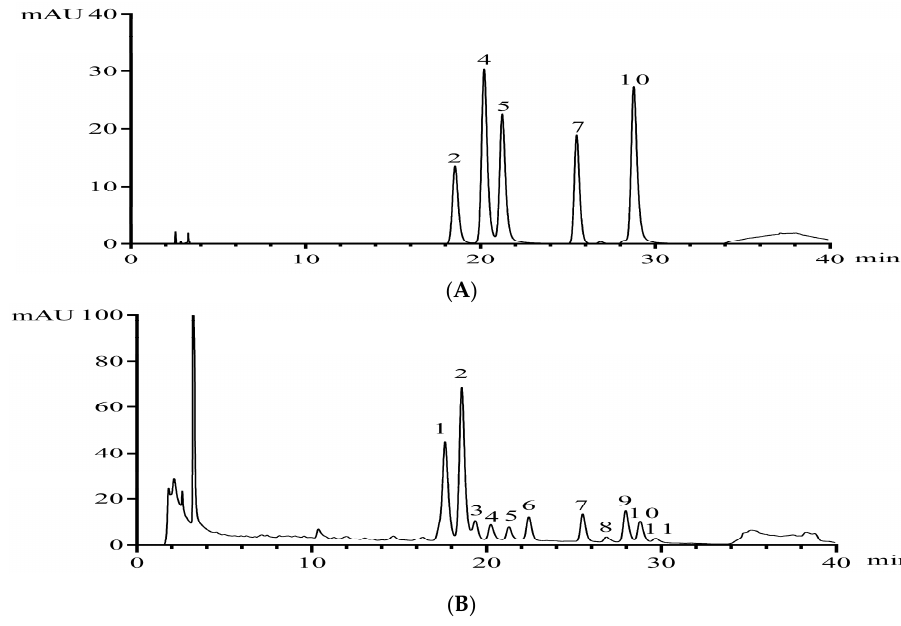
Figure 1. A representative high performance liquid chromatography (HPLC) chromatogram acquired at 350 nm of ( A ) flavonoid standards ( B ) flavonoids in flavonoids from Ziziphus jujuba cv. Jinsixiaozao (ZJF). Peaks were tentatively identified as ( 1 ) quercetin-3- O -robinobioside, ( 2 ) quercetin-3- O - rutinoside, ( 3 ) Unidentified, ( 4 ) quercetin-3- O -galactoside, ( 5 ) quercetin-3- O -glucoside, ( 6 )